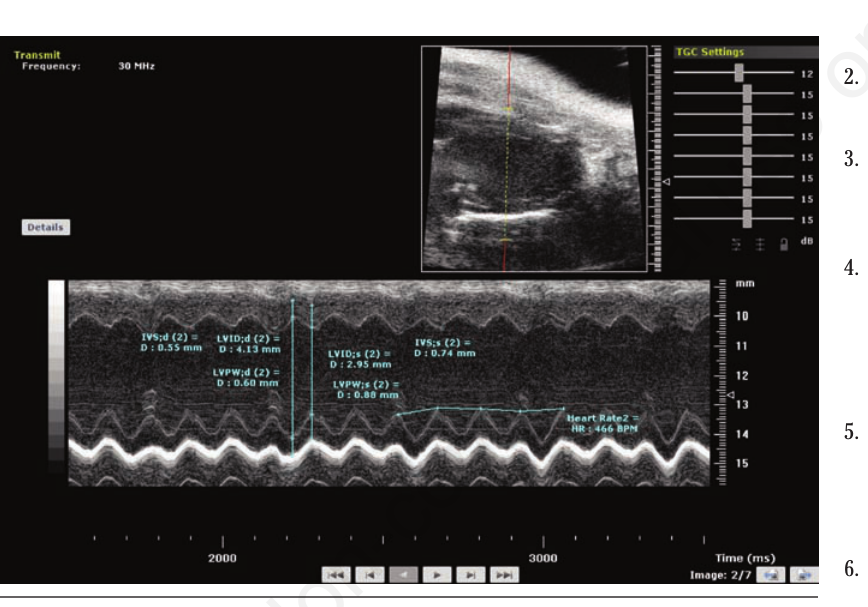
Figure 1. M-mode tracing of the left ventricle. Measurements of the LV dimensions are used for calculation of LV shortening fraction, LV ejection fraction and LV mass.